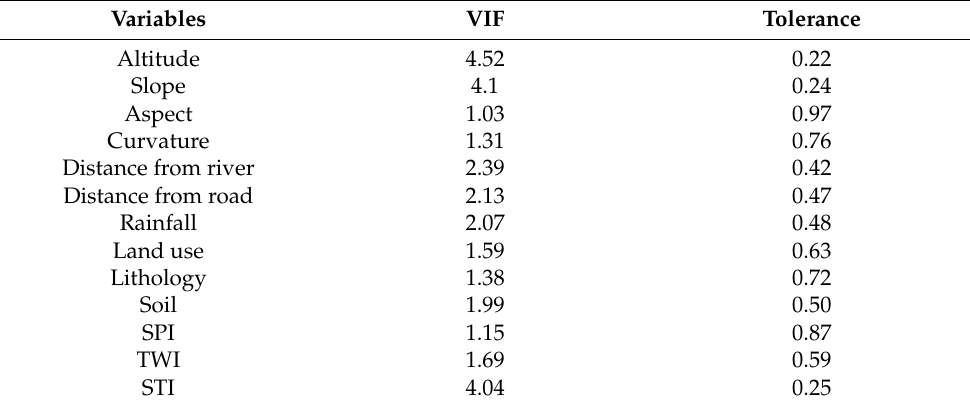
Table 4. Multicollinearity analysis for linearity detection within the independent variables.